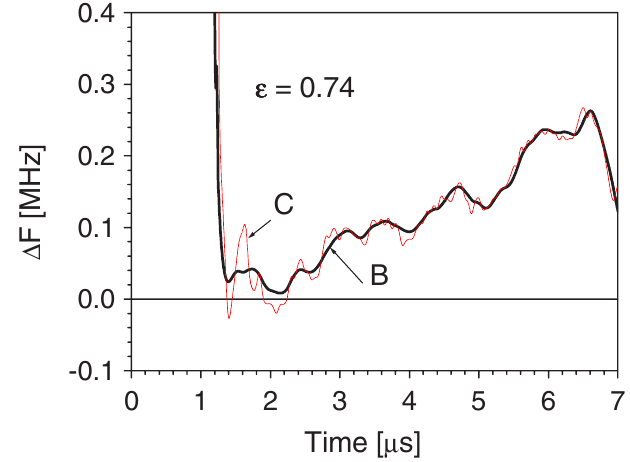
FIG. 10. (Color) B—deviations of the frequency in the micro- tron accelerating cavity. C—bunch repetition rate deviations of the extracted